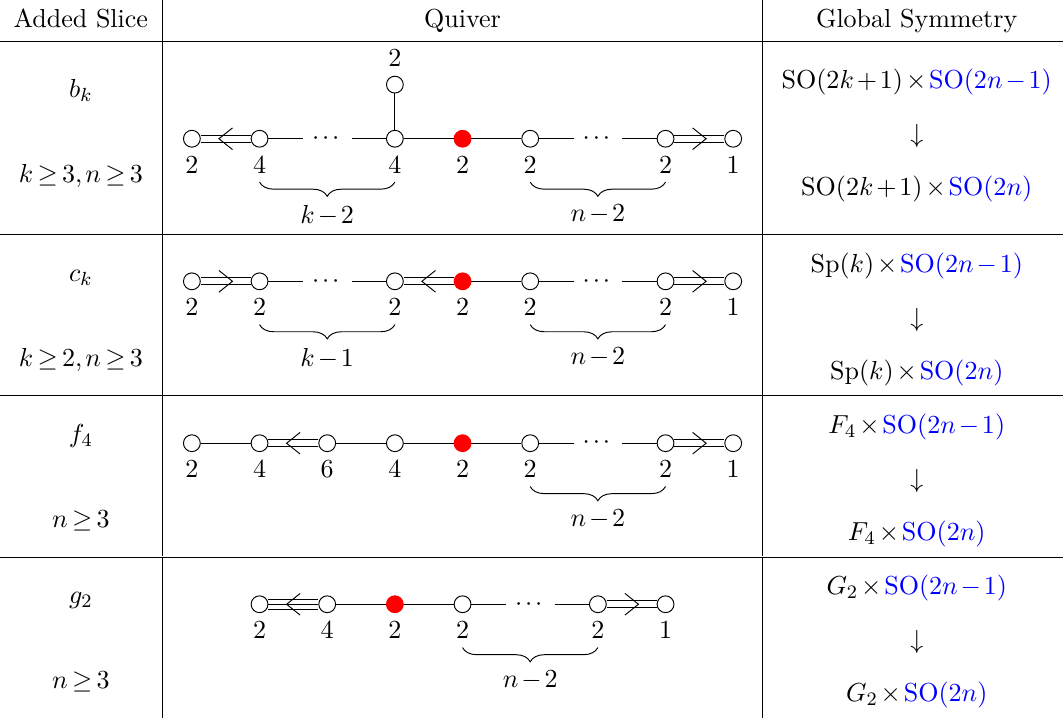
Table 18 . Quivers resulting from adding all possible non-simply laced slice to the empty nodes of n.min D (6.1) to absorb a for n ≥ 3 n